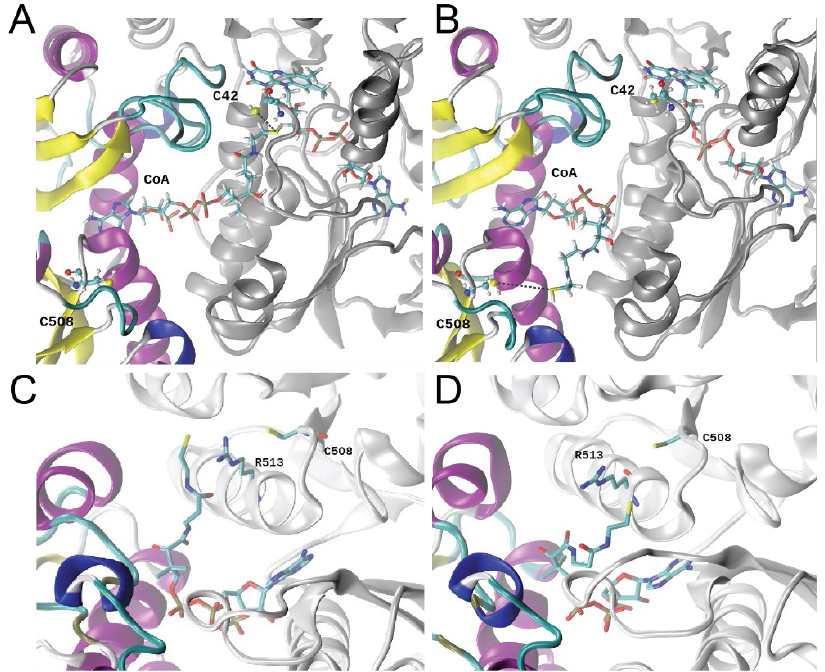
Figure 6. Representative snapshots of stable conformations of CoA relative to C508, obtained from 1.4 µs MD simulations. ( A ) Starting “extended” CoA conformation, protomer B; ( B ) representative “bent” CoA conformation, protomer B. The dimer backbone is depicted in the ribbon, with the CDR domain of one protomer colored based on a secondary structure and the rhodanese domain from the adjacent subunit shaded silver. All residues are depicted with sticks. The position of the pantothenate arm is slightly different in replica 1 ( C ) vs. replica 2 ( D ). approaching C508 from opposite sides of the R513 side chain (shown in sphere and stick).